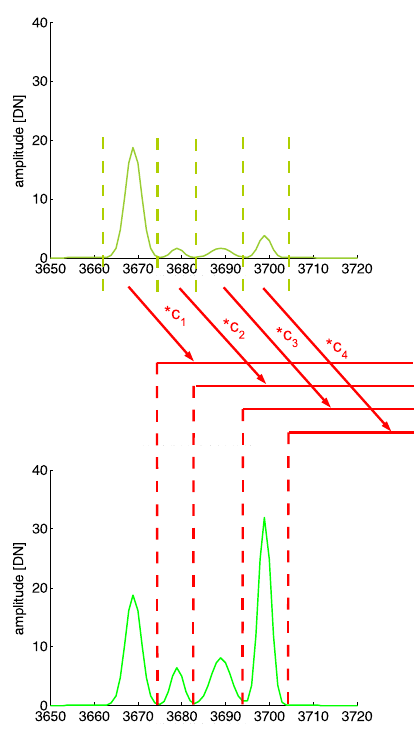
Figure 1: Discrete attenuation correction ([DN] digital number)